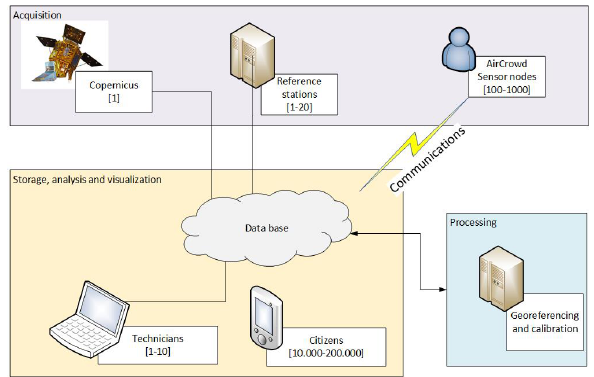
Figure 4. Architecture of the Crowd-sourced Air Quality Monitoring